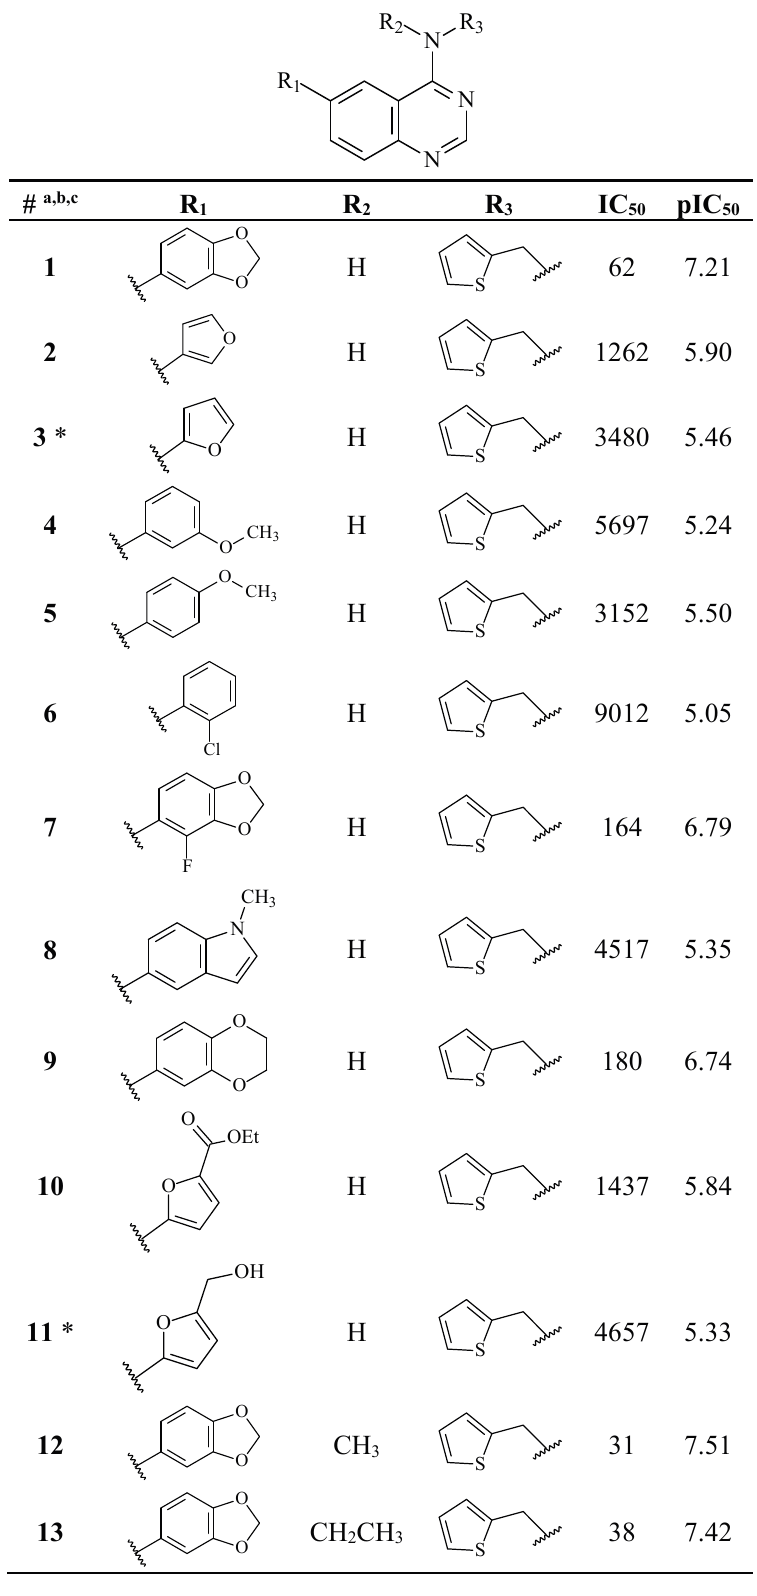
Table 7. Biological activities (IC 50 , nM) and its negative logarithmic values (pIC 50 , M) for a series of 6-arylquinazolin-4-amine derivatives